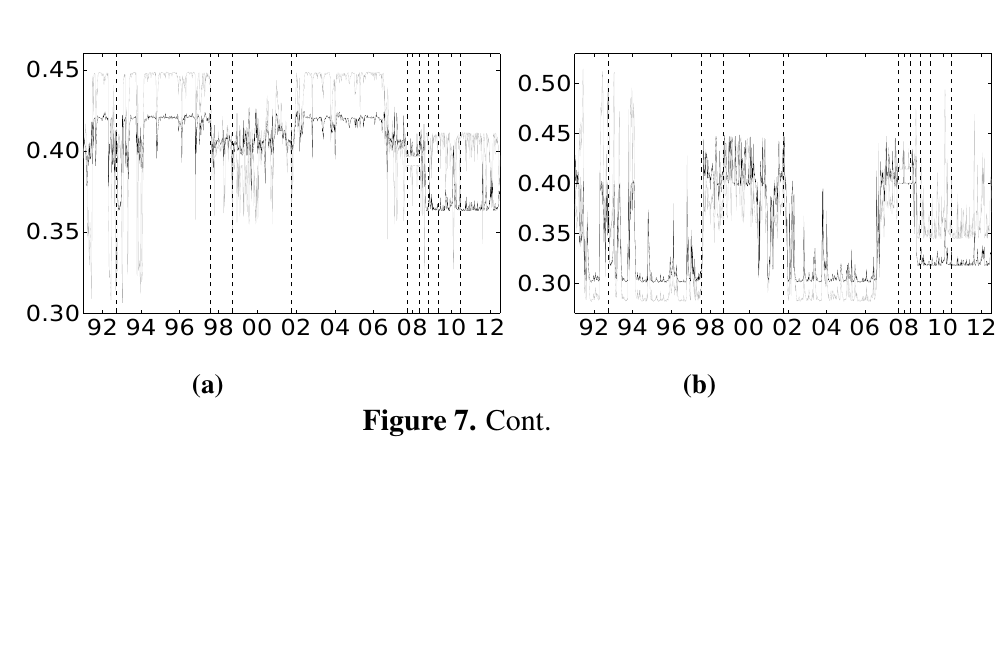
Figure 6. Comparisons of Shapley values ∆ M CoVaR for the different sectors. Vertical dotted lines represent major financial downturns: see Figure 1 for a detailed description. ( a ) Distress of banks on financial services (dark) and vice versa (light gray); ( b ) distress of banks on life insurance (dark) and vice versa (light gray); ( c ) distress of banks on non-life insurance (dark) and vice versa (light gray); ( d ) distress of financial srvs on life insurance (dark) and vice versa (light gray); ( e ) distress of financial servis on non-life insurance (dark) and vice versa (light gray); ( f ) distress of life insurance on non-life insurance (dark) and vice versa (light gray).